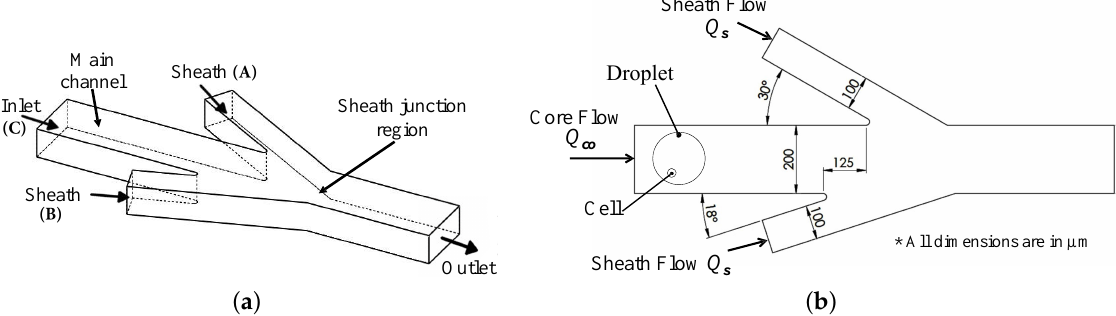
Figure 4. Schematic of the sheath flow microchannel, consisting of three inlet ports: one for core flow and two for sheath flow: ( a ) microchannel inlets and outlet, and ( b ) microchannel